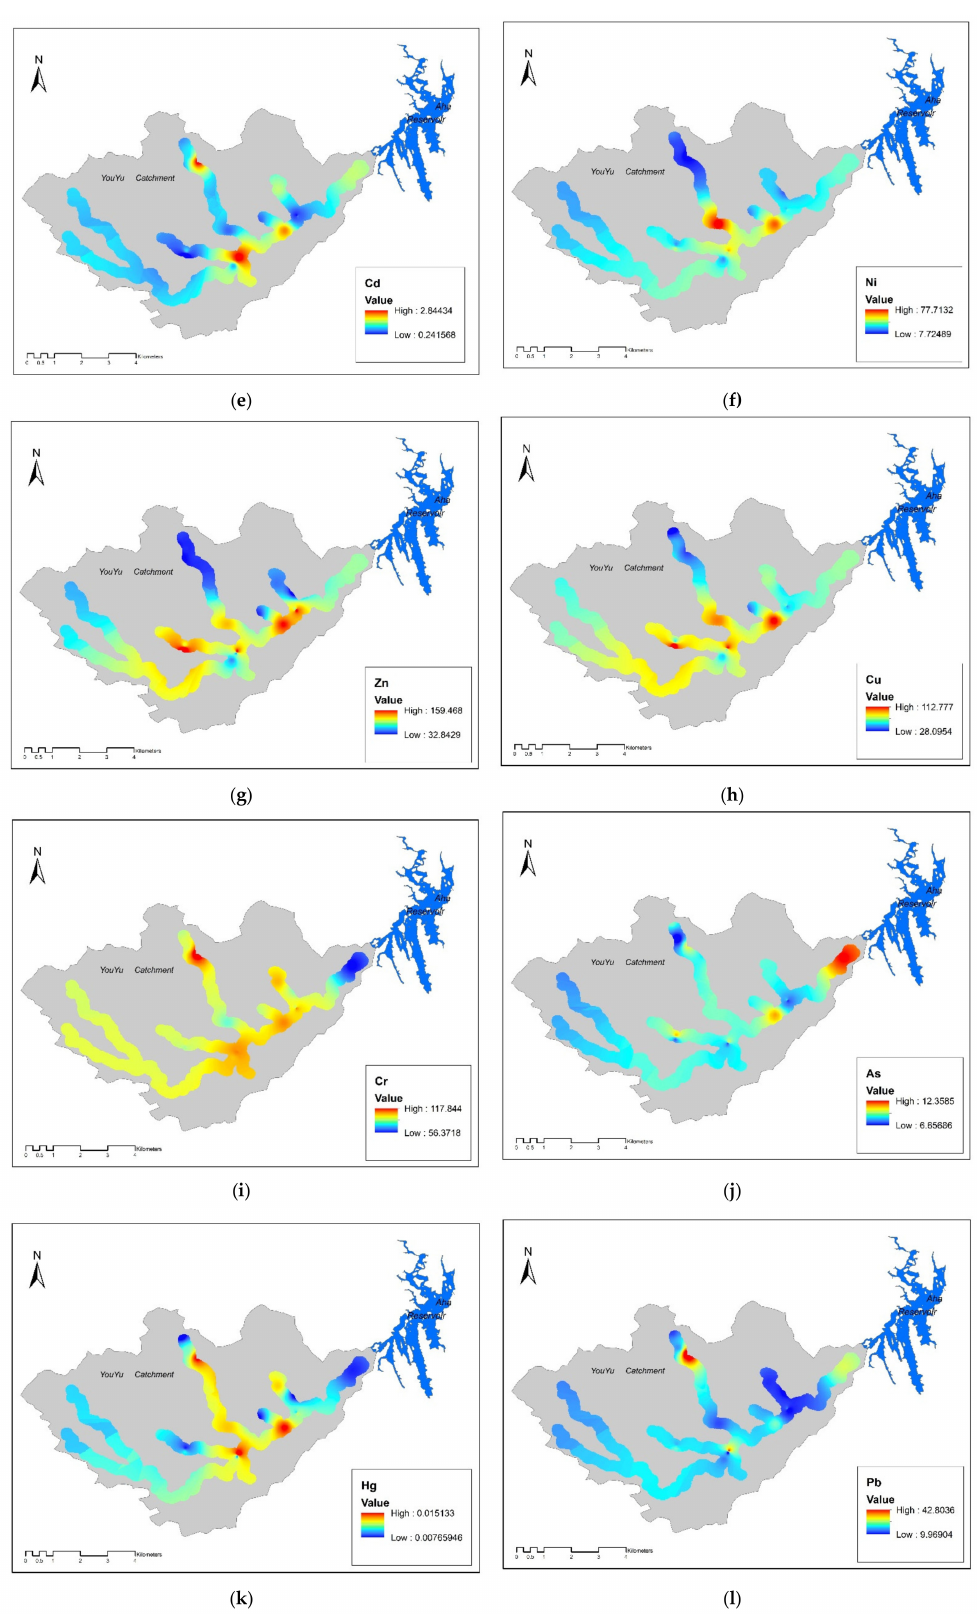
Figure 3. Spatial distribution of the concentrations of potential toxic elements inYouyu catchment. ( a ) pH value; ( b ) S value; ( c ) Fe value; ( d ) Mn value; ( e ) Cd value; ( f ) Ni value; ( g ) Zn value; ( h ) Cu value; ( i ) Cr value; ( j ) As value; ( k ) Hg value; ( l ) Pb